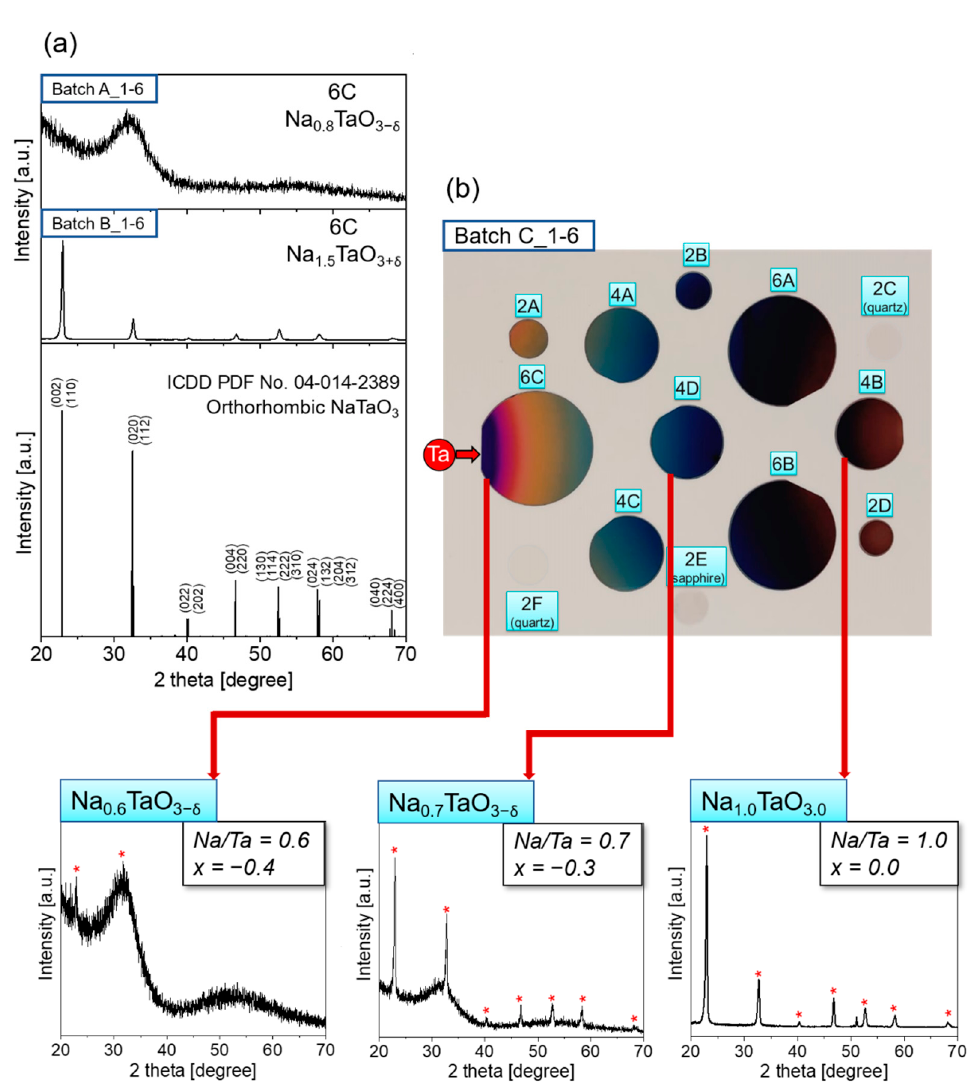
Figure 6. ( a ) XRD patterns of the sample located in 6C position in batches A_1-6 and B_1-6. ( b ) Photographic picture of the batch C_1-6 with the XRD patterns of the samples 6C, 4D, and 4B.